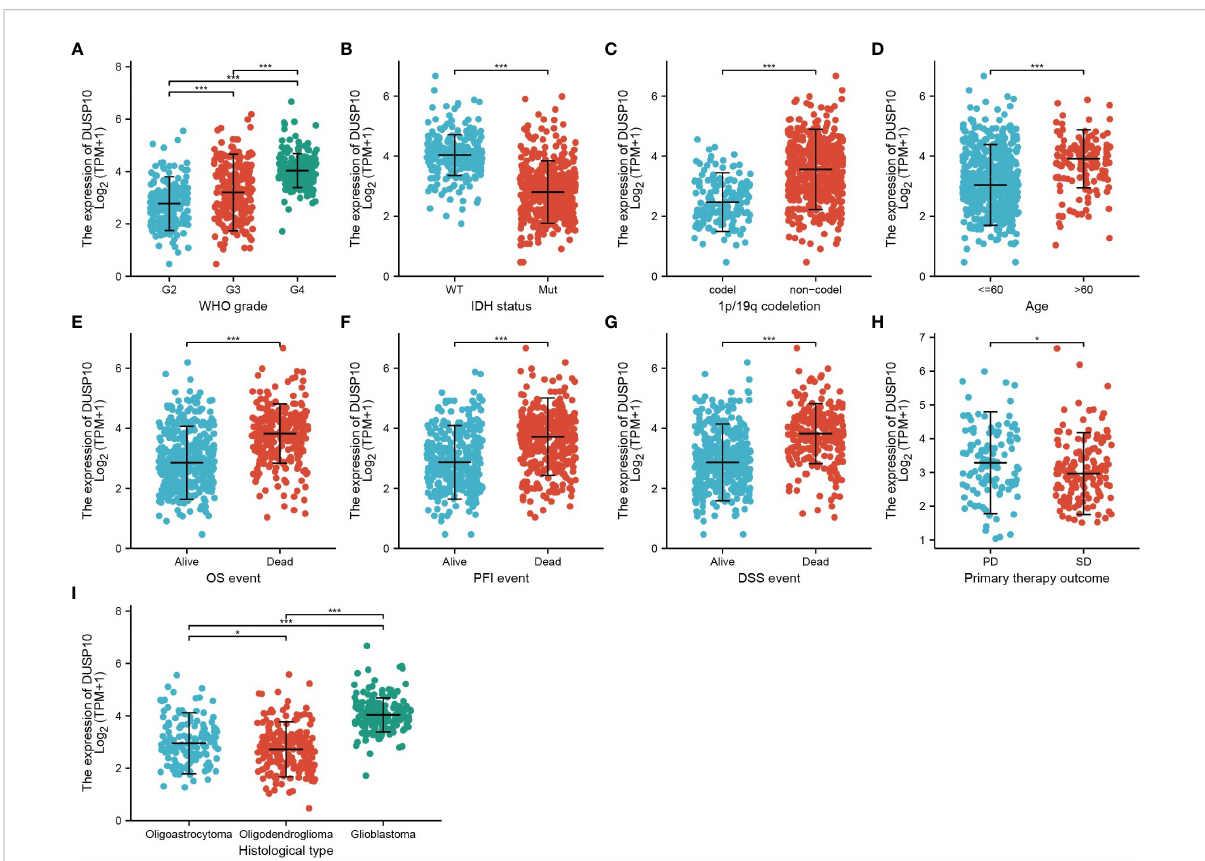
FIGURE 2 Analysis of the relationship between DUSP10 expression and the clinical features of patients included in TCGA glioma dataset (A – I) . Analysis of the relationship between DUSP10 expression and the clinical features of patients included in TCGA glioma dataset, including WHO grade, IDH, 1p/19q codel, age, clinical outcomes events, and histological type. * p < 0.05, *** p < 0.001. IDH, isocitrate dehydrogenase; WT, wild type; Mut, mutant; OS, overall survival; PFS, progression-free survival; DSS, disease-free survival; PD, progressive disease; SD, stable